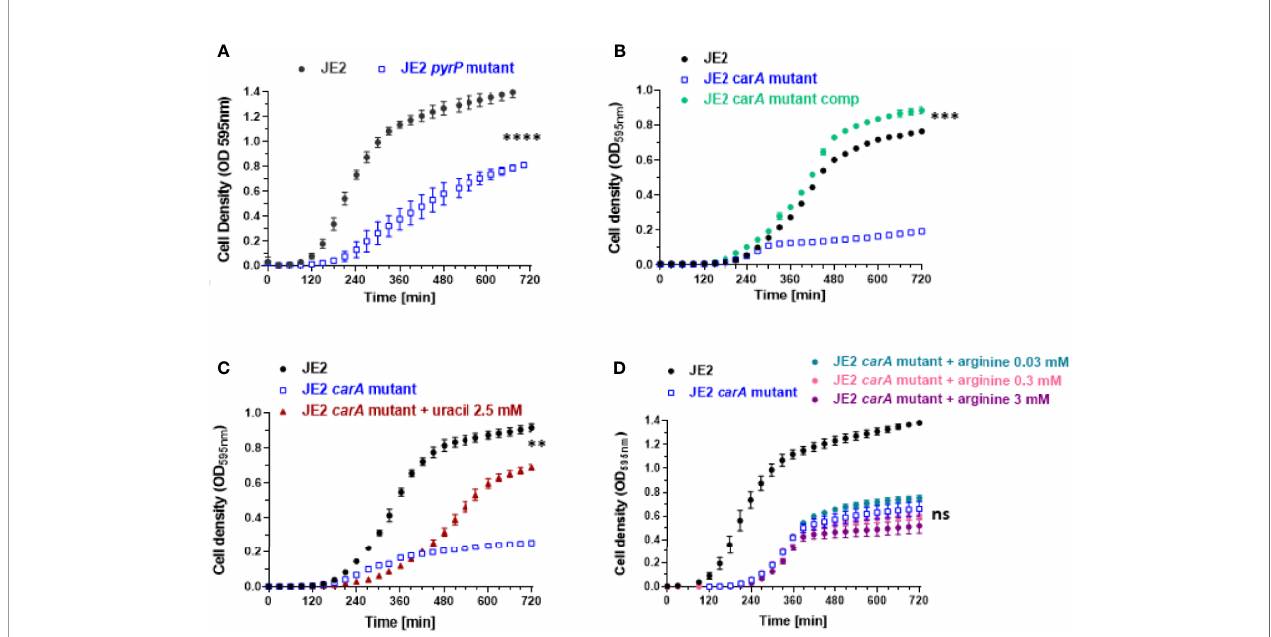
FIGURE 4 | Effect of carA and pyrP mutations on bacterial growth and partial rescue of carA mutant with uracil and carA complementation. (A, B) Bacterial growth analysis of wild-type S. aureus JE2 strain, pyrP and carA mutants (from the Nebraska transposon mutant library) and carA mutant carrying a multicopy plasmid expressing carA (JE2 carA mutant comp). (C) Partial growth restoration of carA mutants after supplementation of 2.5 mM of uracil in the medium. (D) Absence of growth restoration with different arginine concentrations. Results represent the mean ± SD of three independent experiments (four replicates for each strain).